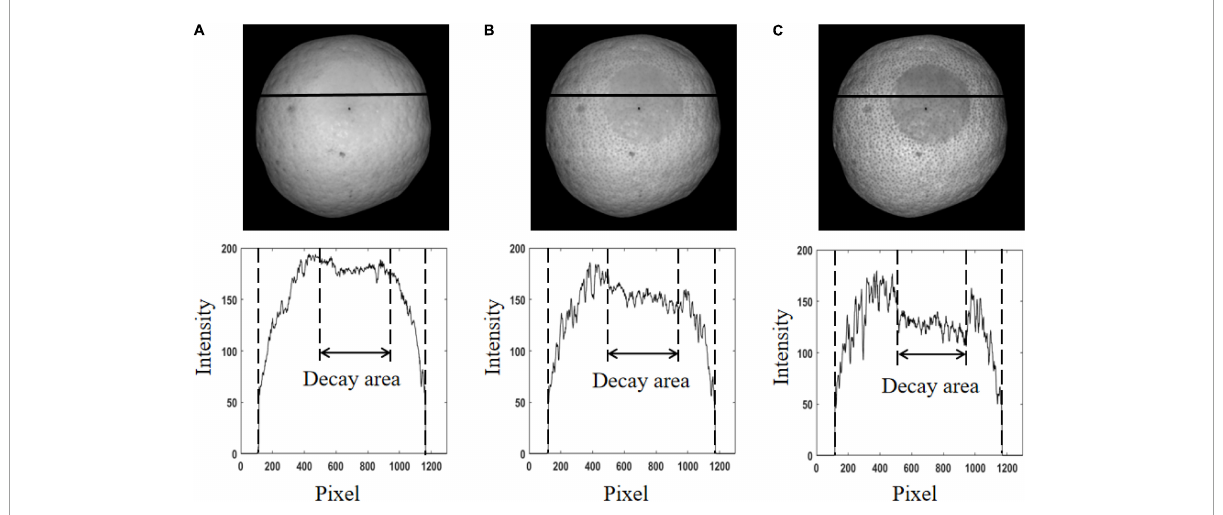
FIGURE5 The demodulated AC images and intensity distribution curves. (A) The spatial frequency of 0.05 cycles mm − 1 . (B) The spatial frequency of 0.15 cycles mm − 1 . (C) The spatial frequency of 0.25 cycles mm − 1